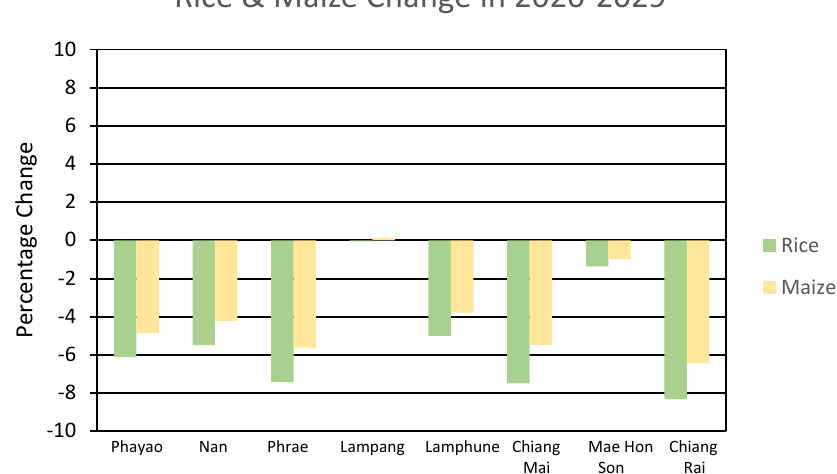
Figure 6. Percentage change of rice and maize in 2020–2029 compared with 2010–2018.